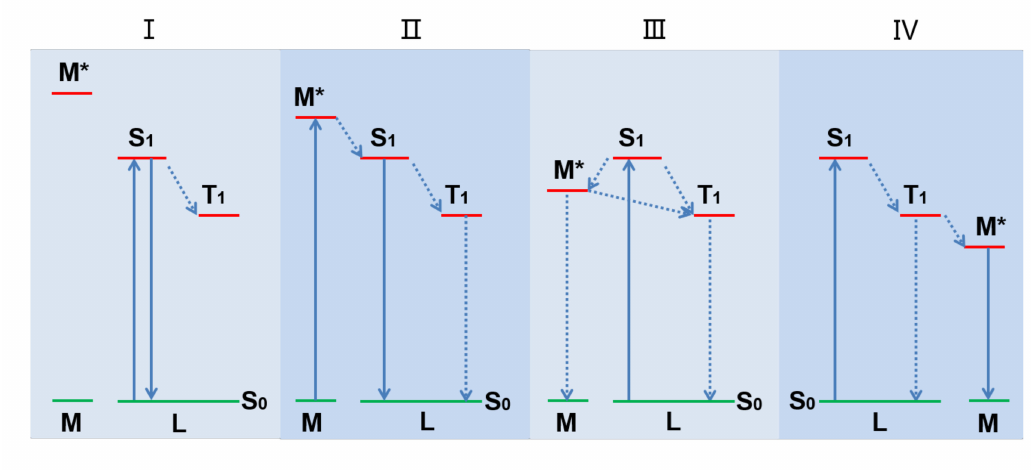
Figure 1. The excited state charge transfer mode between metal ion and organic ligand of metal